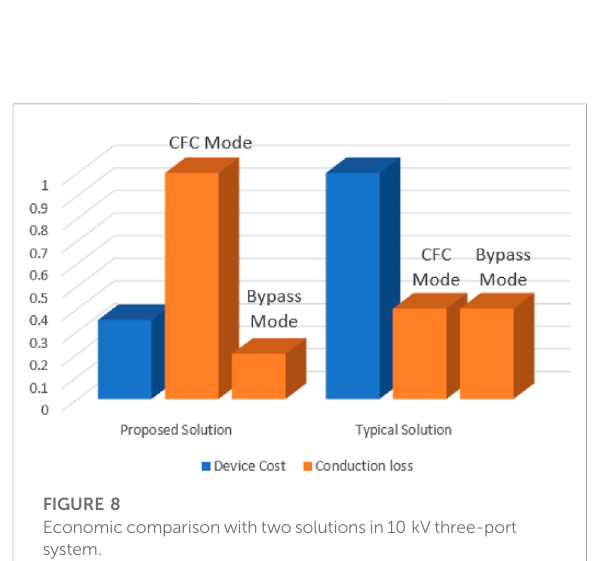
FIGURE 8 Economiccomparisonwithtwosolutionsin10 kVthree-port